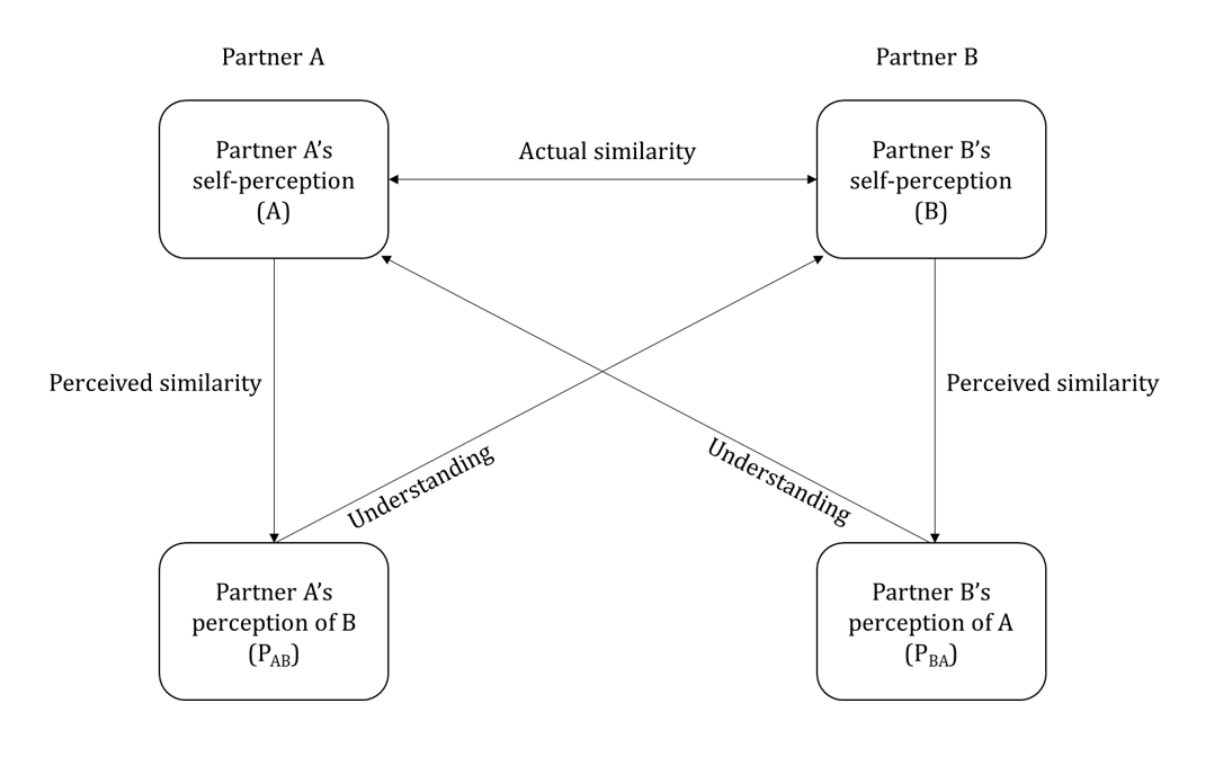
Figure 1. Reproduction of the model of perceptual congruence from Acitelli et al [33], presenting the 3 variables of perceptual congruence between partners in a romantic relationship. Arrows do not indicate a causal link but a